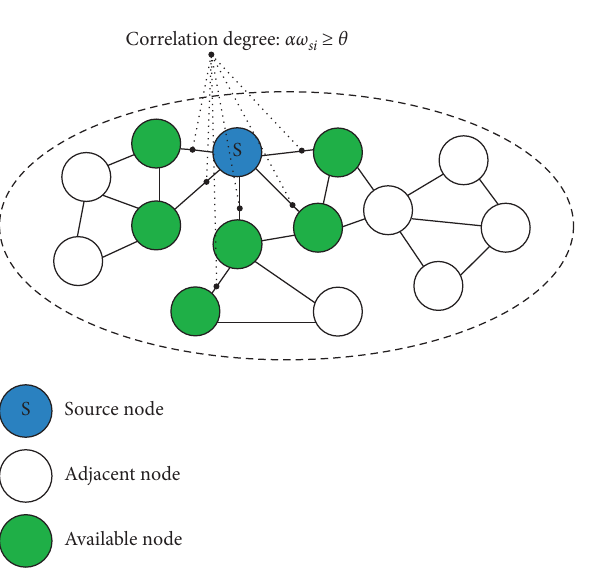
Figure 1: Data delivery on communication domain.